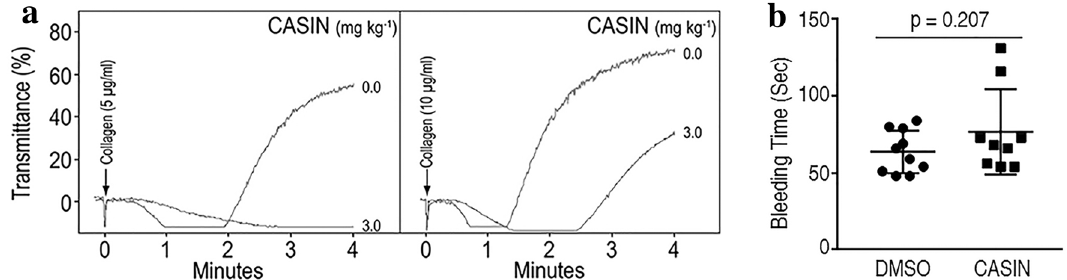
Figure 5. Administration of CASIN to mice inhibited ex vivo platelet aggregation without affecting murine tail bleeding times. ( a ) Intra-peritoneal administration of CASIN (3 mg/kg) inhibited collagen-induced aggregation in citrated platelet rich plasma prepared from four. DMSO and 4 CASIN treated C57BL/6 wild type mice per experiment. Platelet aggregation was monitored by a standard optical density method using a dual channel Lumi-Aggregometer from Chrono-Log Corporation. ( b ) Murine tail bleeding times were assessed 20 min after Intra-peritoneal administration of CASIN (3 mg/kg). CASIN did not affect the tail bleeding times (DMSO n = 10, CASIN n = 9, p =